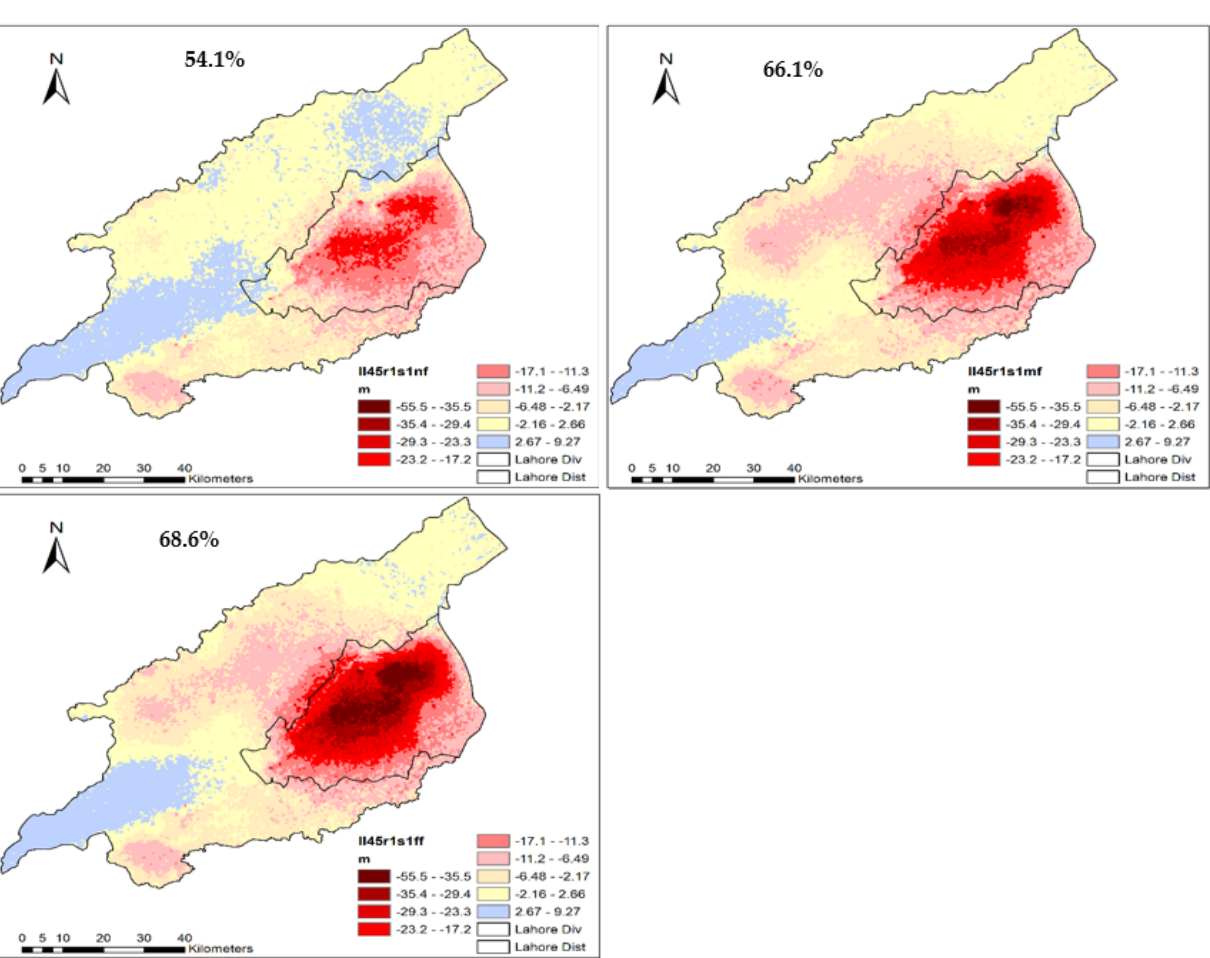
Figure 10. Spatial distribution of groundwater levels in Lahore under RCP4.5R1S1SSP1 scenarios. Near future ( top left ), mid future ( top right ) and far future ( bottom ). Note: Numbers in the top right corner show percentage of the total area with a significant change in impact.